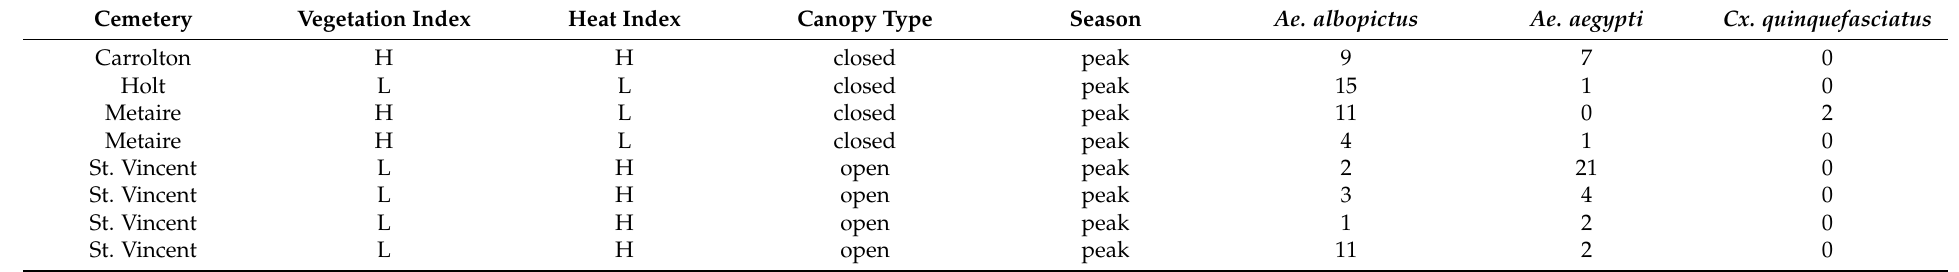
Table A2. Table showing individual samples in which coexistence among species within a container were detected, out of a total of 87 samples. Samples are labeled based on the cemetery where they were collected and characterized in terms of High (H) and Low (L) income, vegetation and heat index. Season in which coexistence was detected (Peak, Not-Peak) is listed, as well as counts for each of the species